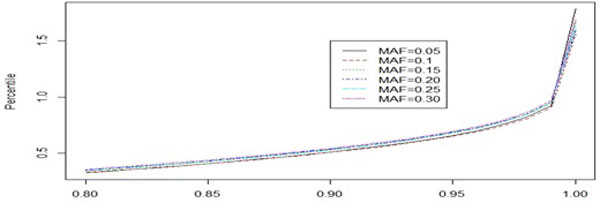
Effect of minor allele frequency (MAF) on the null distribution. Only upper quantiles (from 80%) have been considered as lower quantiles showing almost no difference.